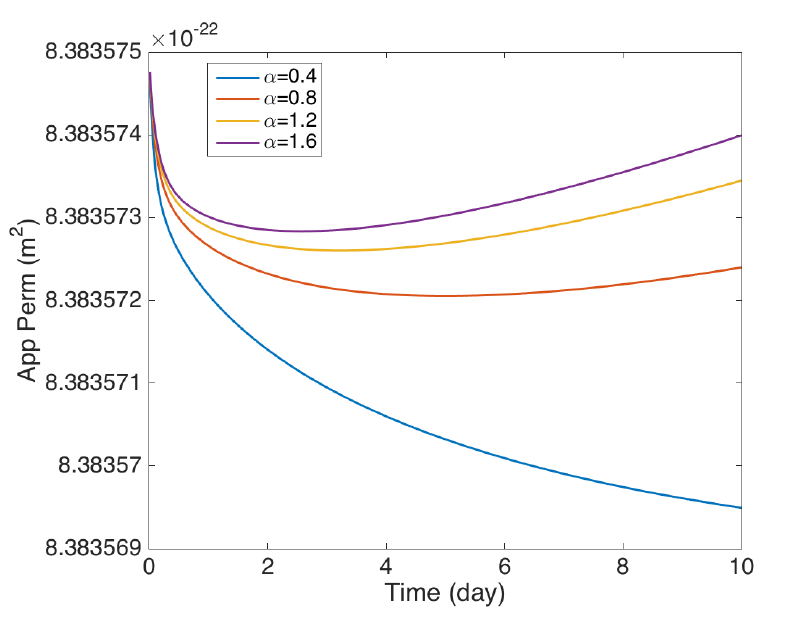
Figure 10. The average apparent permeability for various values of the parameter α .